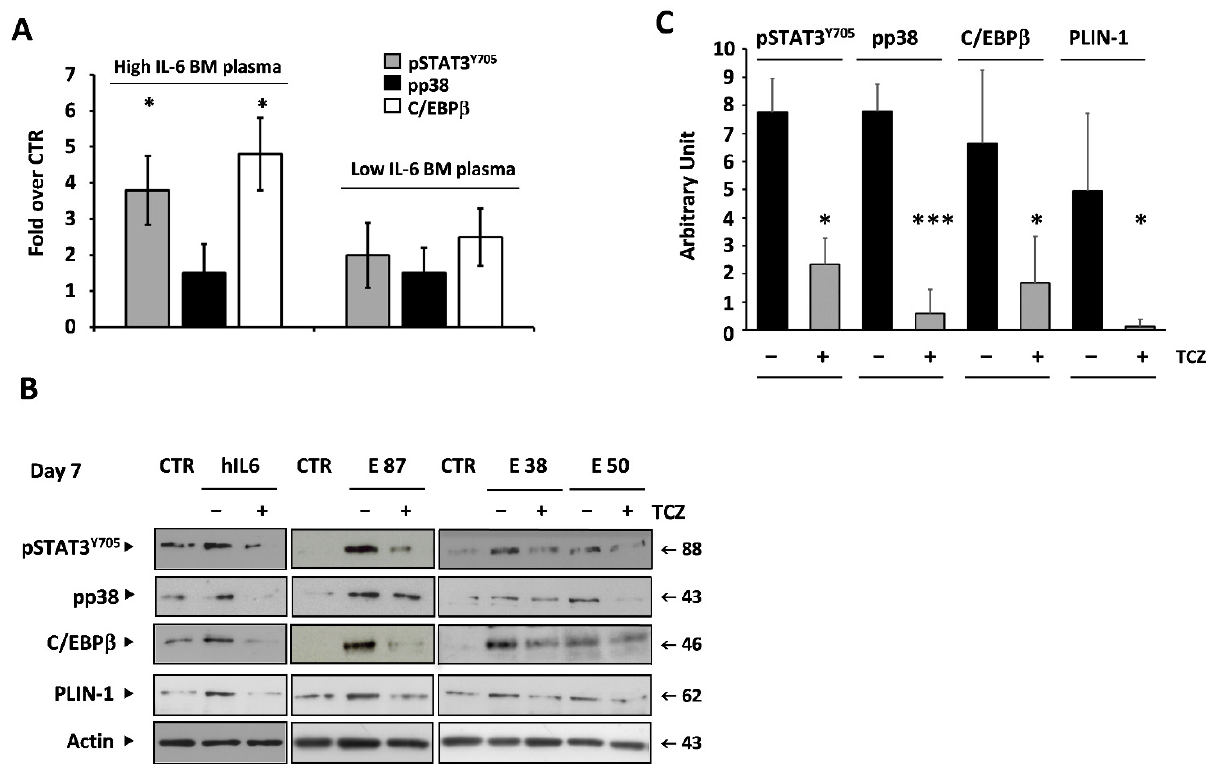
Figure 6. IL-6 mediates the adipogenic effect of elder BM plasma on BM-MSCs, activating the pSTAT3Y705 and C/EBP β pathways and inducing PLIN-1 accumulation in BM-MSCs. ( A ). Diagrams of mean ± SD of pixel densitometry of Western blot analysis of pSTAT3 Y705 , pp38, and C/EBP β induction in BM-MSCs treated with BM plasma from elder donors containing a high or low amount of IL-6. Values are calculated as fold increase over control. ( B ). Crude lysates (10 µ g) of BM-MSCs treated with recombinant human IL-6 (3 ng/mL) or BM plasma from elder donors (final concentration 20%) in the presence or absence of TCZ (20 µg/mL) immunoblotted with the indicated mAbs. β -Actin ensured equal loading in the lanes. Arrows indicate relevant bands in all panels. ( C ). Pixel densitometry of B. Values are the mean ± SD of area pixels obtained in at least three independent experiments. * p < 0.05, *** p < 0.001.